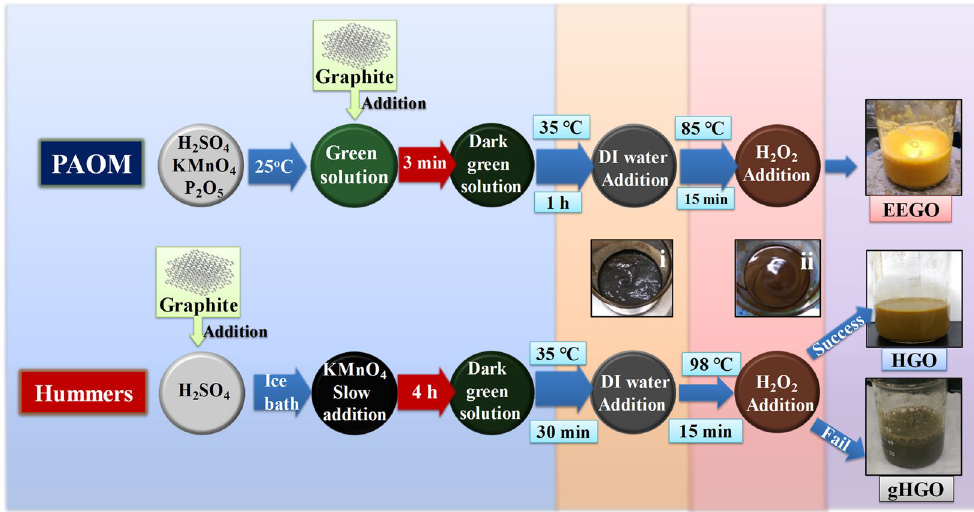
Figure 1. GO preparation by PAOM and conventional Hummers’ approaches. Photograph i and ii illustrate the physical appearance of the intermediate